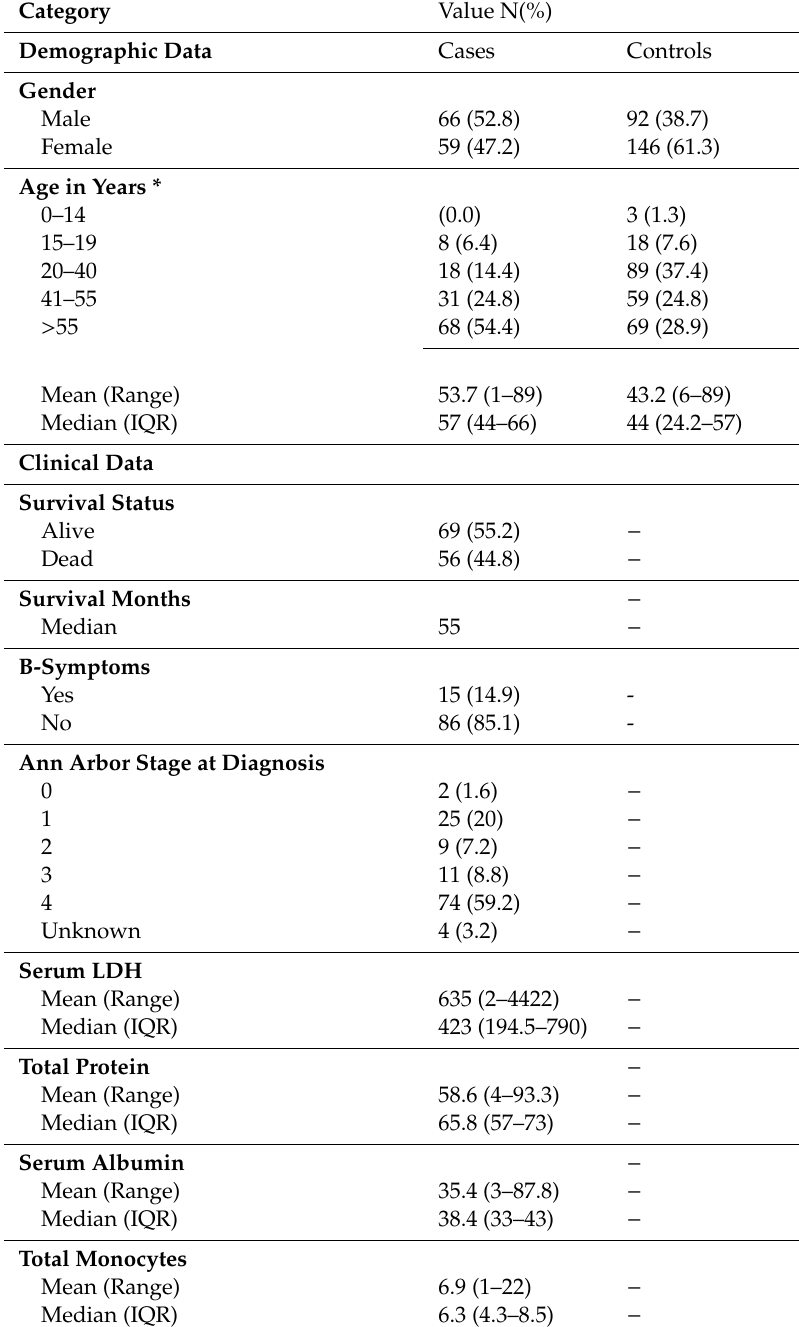
Table 1. Demographic and clinical data of 125 di ff use large B-cell lymphoma (DLBCL) patients of Jordanian Arab descent in this